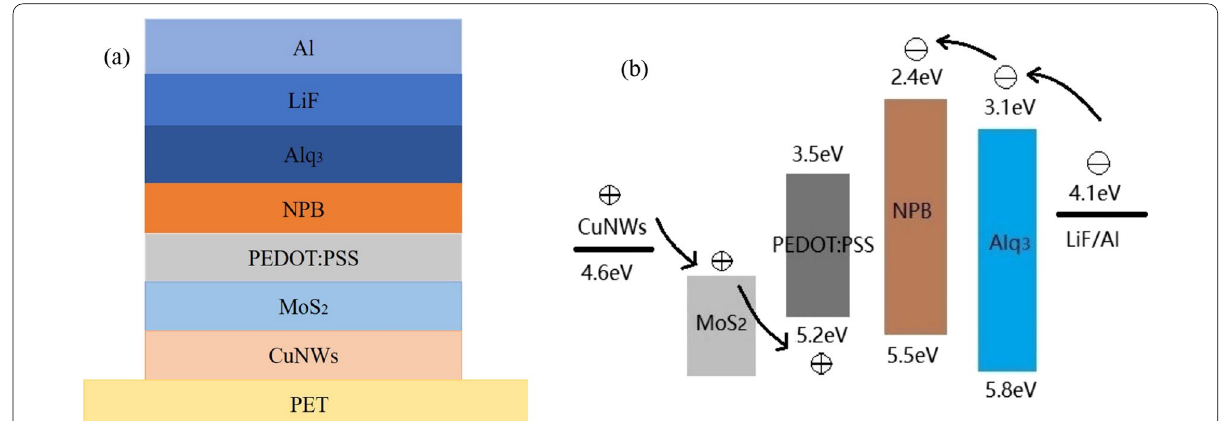
Fig. 2 The device structure and energy level of the OLED. a The device structure diagram of the OLED. b The energy level structure diagram of the OLED